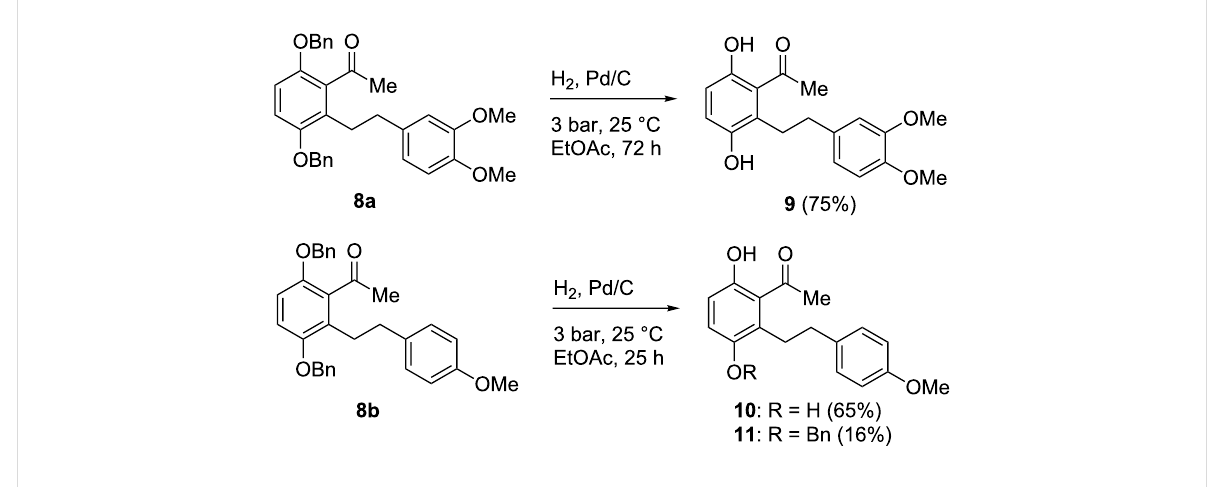
Scheme 3: Cleavage of benzyl protecting groups in ketones 8a and 8b . Synthesis of scorzodihydrostilbene aglycon 9 .